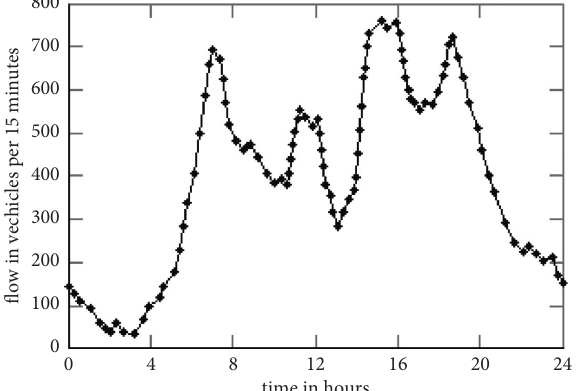
Figure 4: Traffic flow in vehicles per 15 minutes over 24 hours.